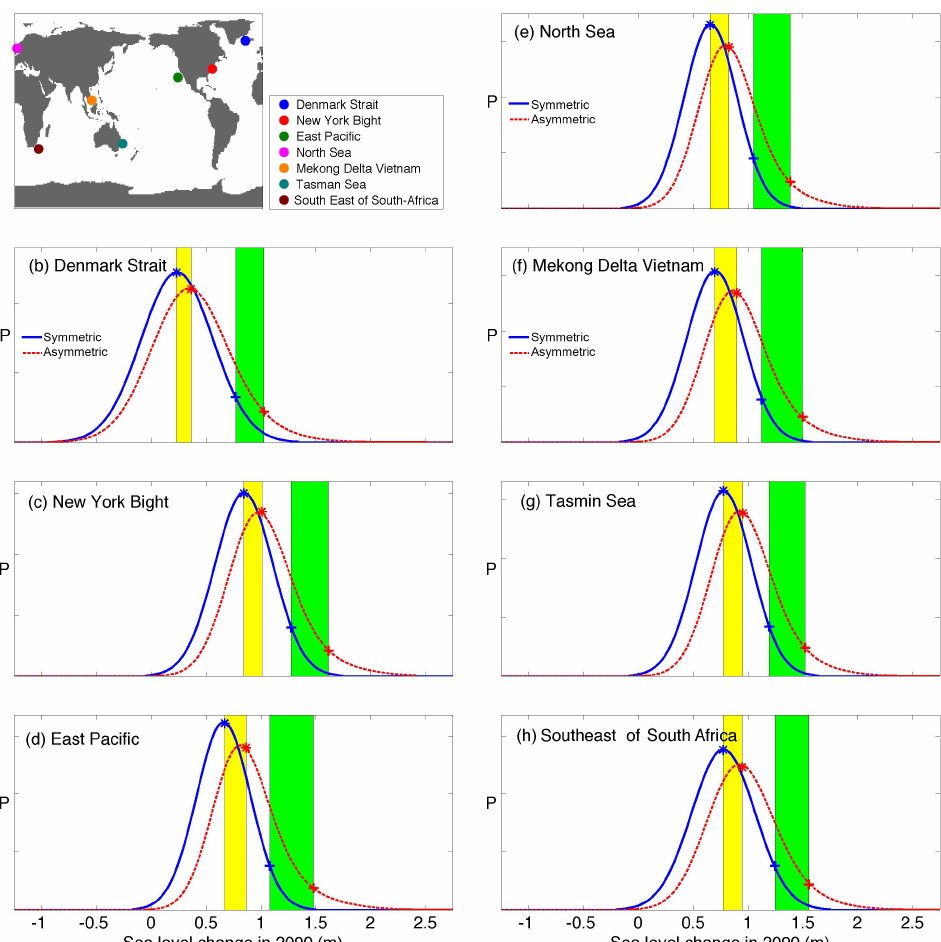
Figure 4. Total combined probability density of sea level change by 2090, for three locations marked in panel (a) : (b) Denmark Strait, (c) New York Bight, (d) east Pacific, (e) North Sea, (f) Mekong Delta Vietnam, (g) Tasmin Sea (east of Australia) and (h) southeast of South Africa. Regional projections by Slangen et al. (2014) following RCP8.5 combined with (blue, solid lines) the symmetrical IPCC-based distributions of ice sheet mass loss and (red, dotted lines) asymmetrical VW15-distribution of ice sheet mass loss. The stars indicate the median and the plus sign indicate the 95th percentile. The difference in median is indicated in yellow and the difference in the 95th percentile in green. Note that the increase of the 95th percentile is larger than the increase in median. The input distributions for each location are depicted in Fig.